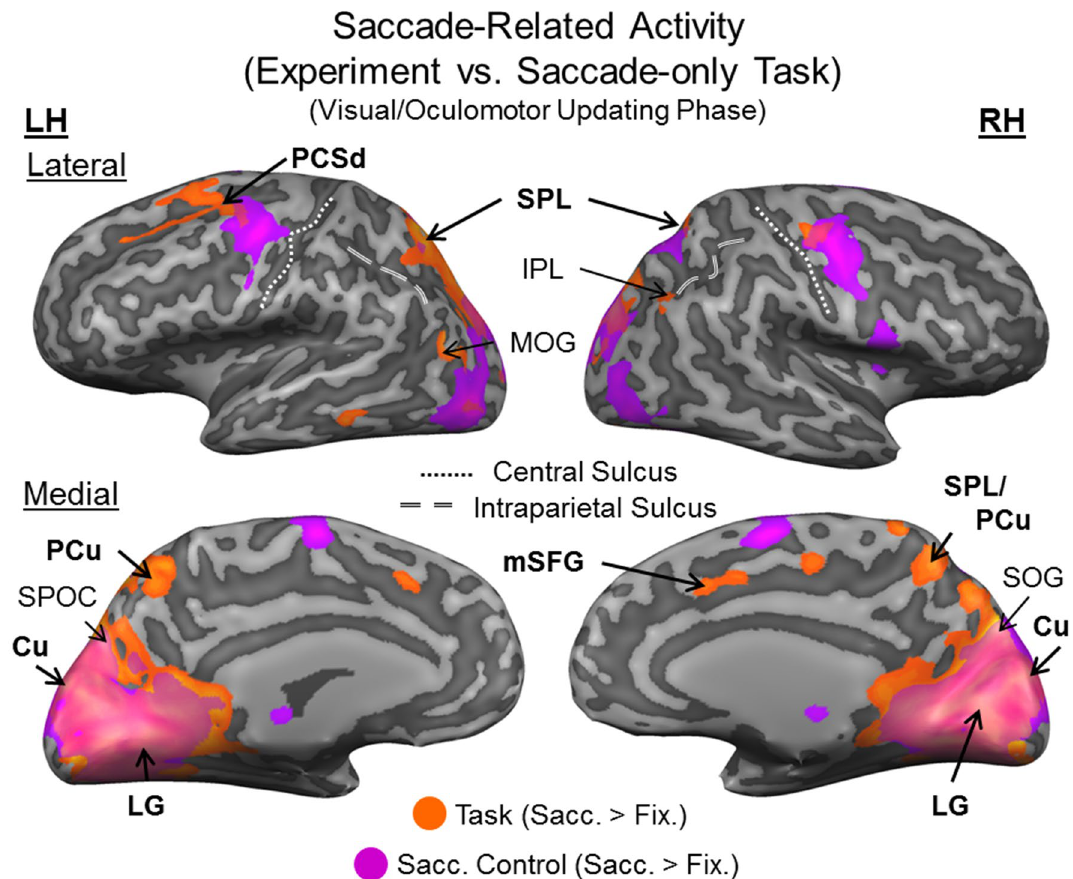
Figure 3. Saccade-related effects during experimental task versus independent saccade task. Voxelwise statistical maps from an RFX GLM for Saccade > Fixation in the experimental task (n = 15; orange; FDR (q < 0.05) and cluster correction) versus the control task (n = 12; fuchsia; FDR (q < 0.05) and cluster correction) are overlaid onto inflated cortical surface renderings of example participant (left hemisphere on the left, right hemisphere on the right; upper panels showing the lateral views, and lower panels showing medial views) (BrainVoyager QX v2.8; www. brain voyag er. com). There is substantial overlap in activity in medial occipital regions for task and saccade control (for example, cuneus, Cu, lingual gyrus, LG, and superior occipital gyrus, SOG). However, experimental task-specific saccade modulations can be observed in particular parietal (precuneus, PCu, and superior parietal lobule, SPL) and frontal saccade regions (medial superior frontal gyrus, mSFG—likely pre-supplementary eye field; dorsal precentral sulcus, PCSd—likely frontal eye field). (Bold regions are those that are subsequently tested against prediction